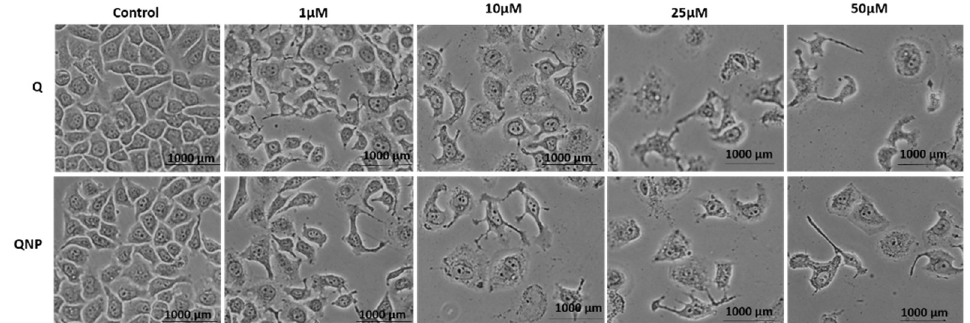
Figure 3. Phase contrast microscopy of the HeLa cell line treated with different concentrations of Q or QNPs for 48 h. The normal morphology of cells was lost at higher